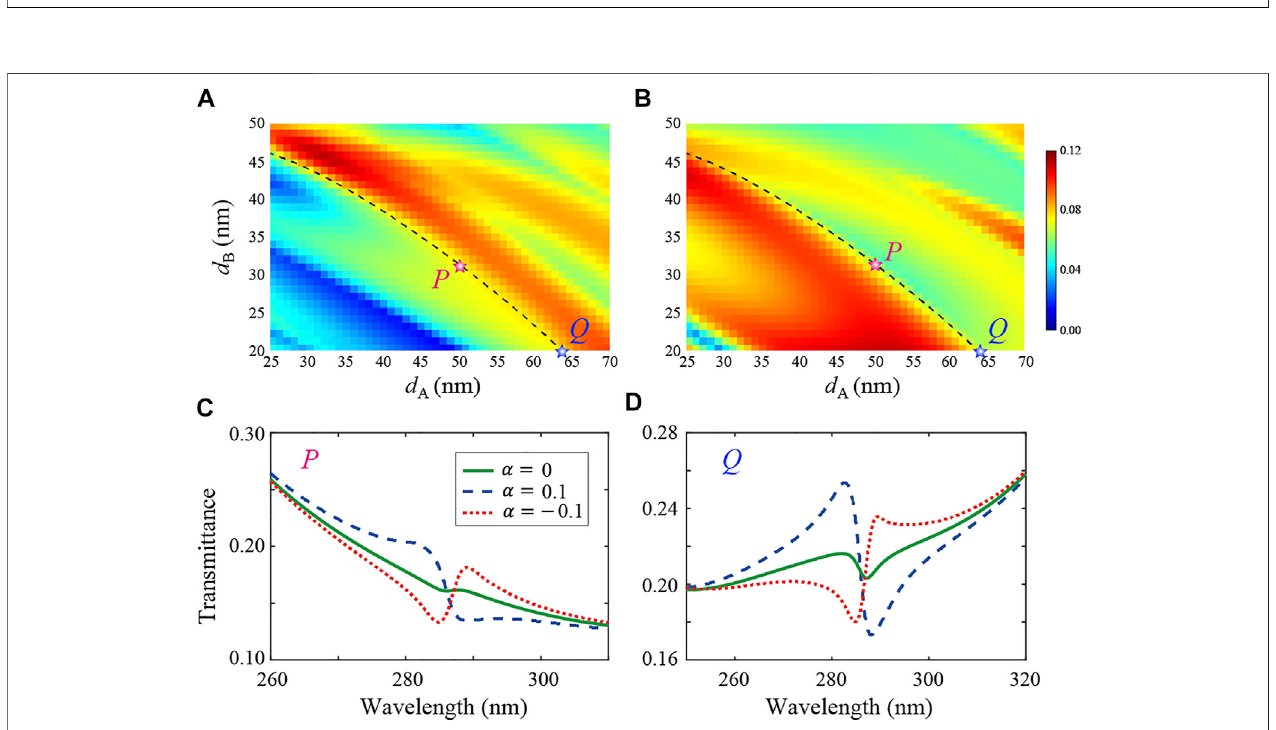
FIGURE5 |(A) Maximum of Δ T 2 asthe function ofthe thickness of layer A and layer B . (B) Similar to (A) ,but forthe maximum of − Δ T 2 .The places where Fano line changes sharply are distinguished by dashed lines. The case d A = 50 nm (63 nm) and d B = 32 nm (20 nm) is marked by P ( Q ). (C) The transmittance spectrum of the composite structure P for different MO coef fi cient: α = 0 (solid green line), α = 0.1 (dashed blue line) and α = − 0.1 (dotted red line), respectively. (D) Similar to (C) , but for the composite structure Q.